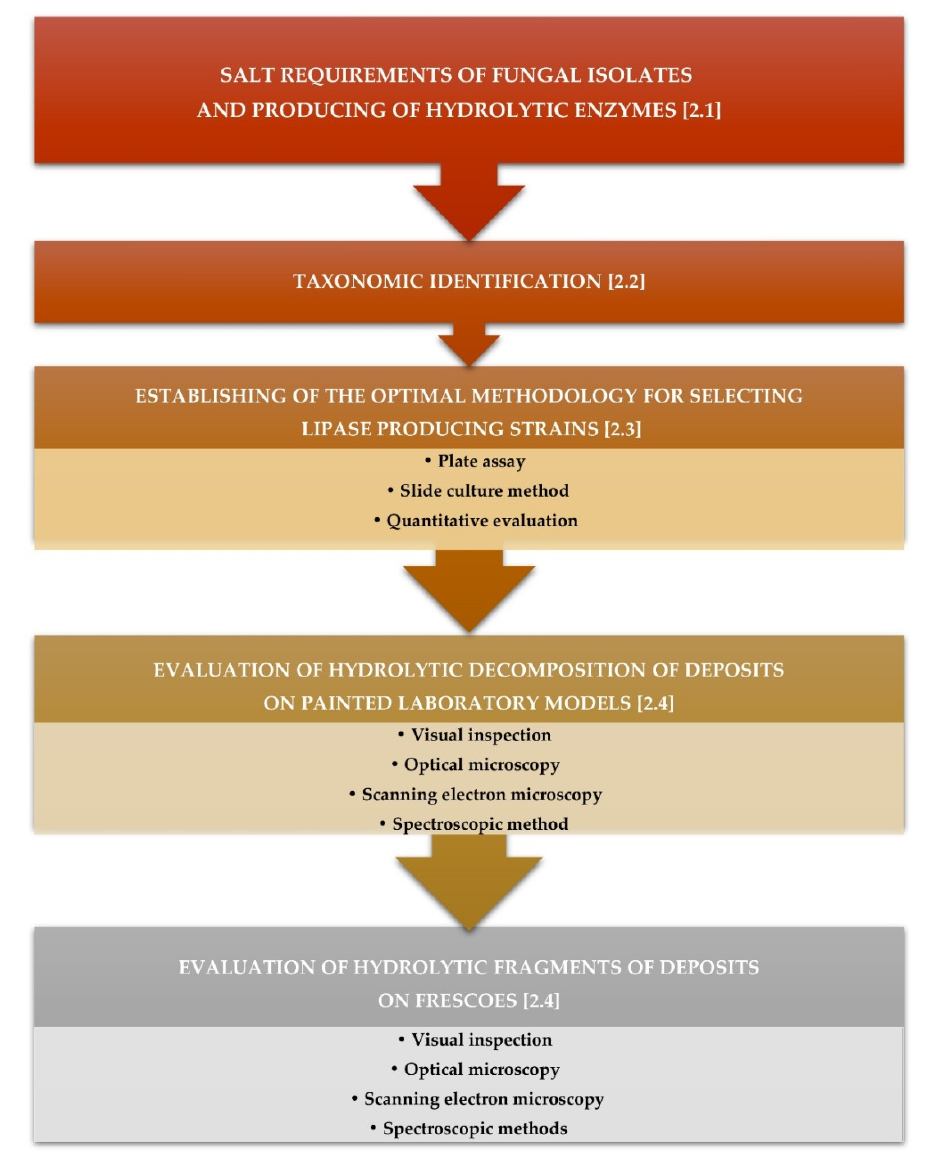
Figure 1. Synopsis of the experiments.